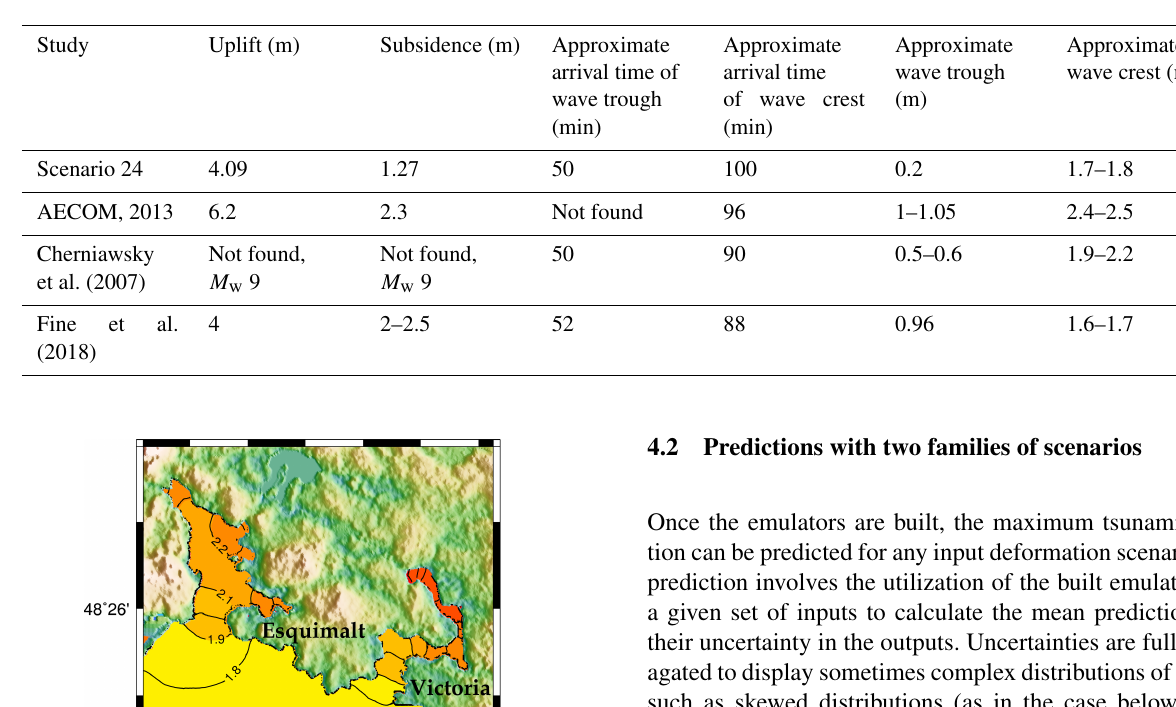
Table 1. Modelling studies of tsunami at the mouth of Victoria Harbour.